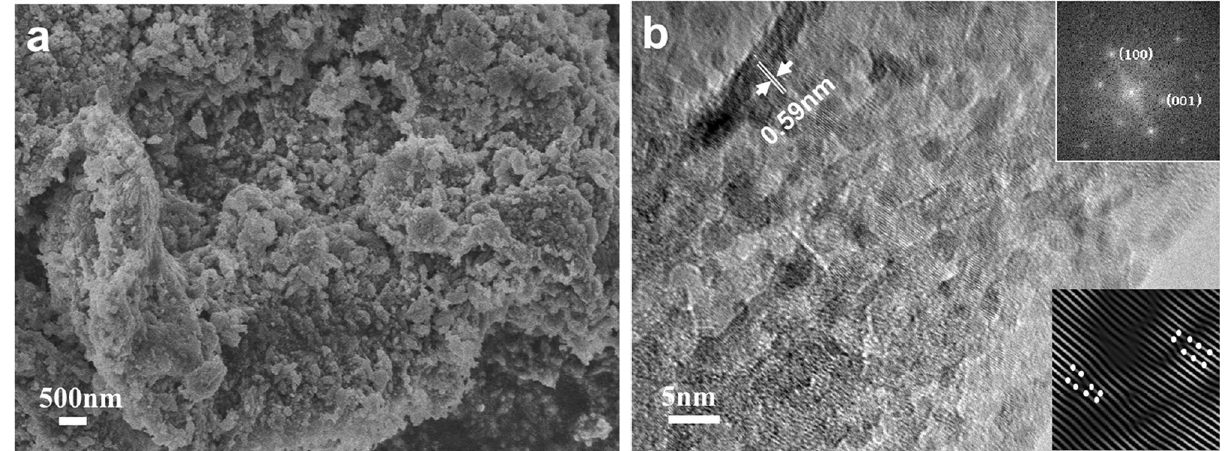
Figure 1. ( a ) SEM image. ( b ) TEM image of carbon ferrite and its corresponding FFT pattern (the inset in the upper right corner of Fig. 1b) and IFFT image (the inset in the lower right corner of Fig. 1b) of the Fe 3 O 4 grains.